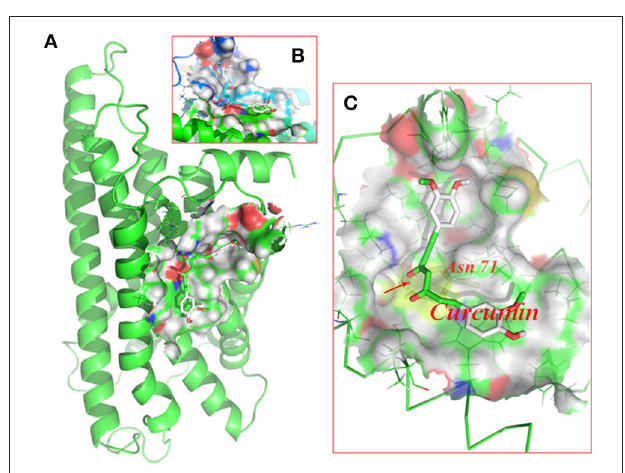
FIGURE 4 | Molecular docking of curcumin on the P2Y12 protein. Simulated model of curcumin docked with the rat P2Y12 protein generated using a computer. Structures in (A) (forward map) and (B) (top view) show the best docking position for curcumin on the P2Y12 protein. (C) The photo indicates the strong binding energy between curcumin and ASN71. Curcumin interacted with rat